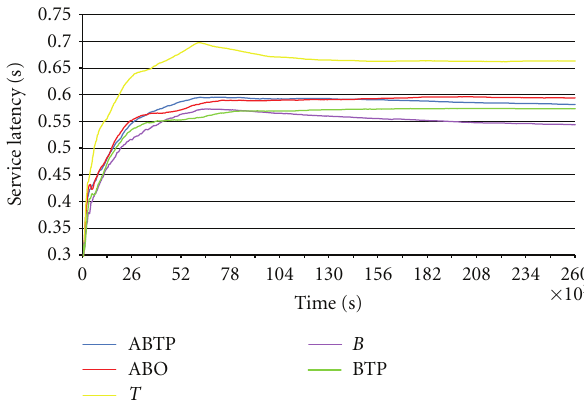
Figure 12: Service latency from di ff erent optimization criteria on MA quantity of 6000.